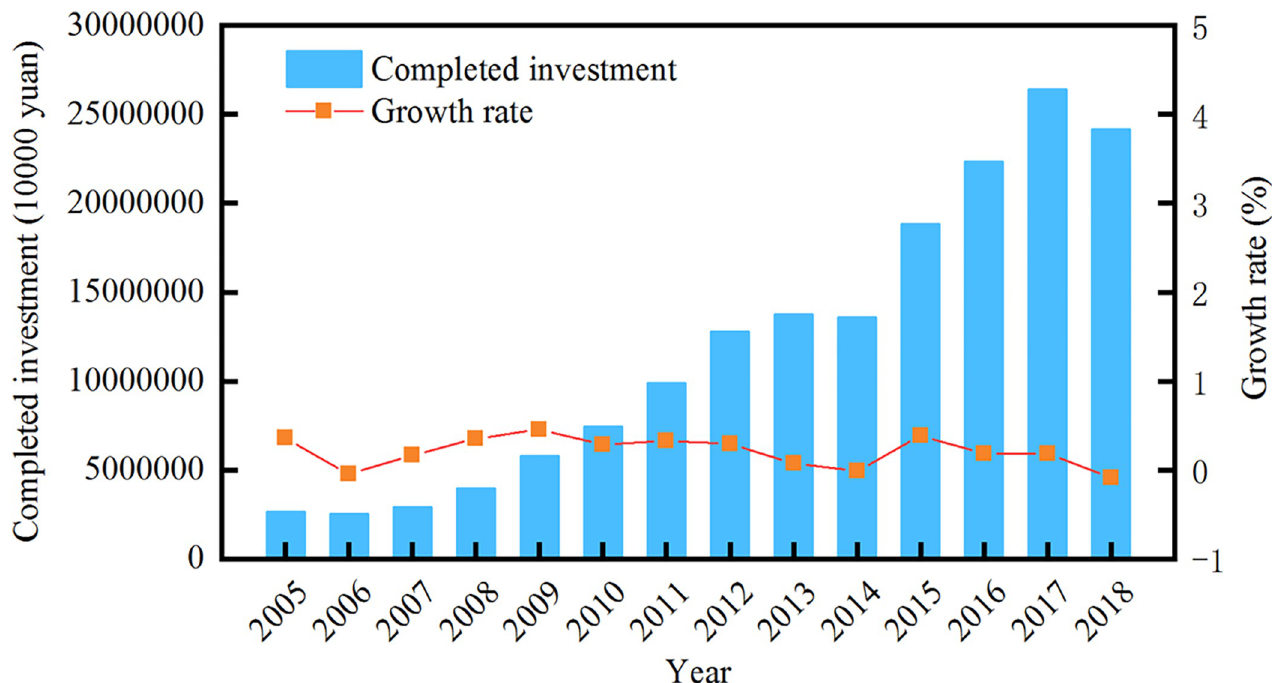
Fig 1. Completed amount and growth rate of agricultural water salvation investment in the Eastern region.